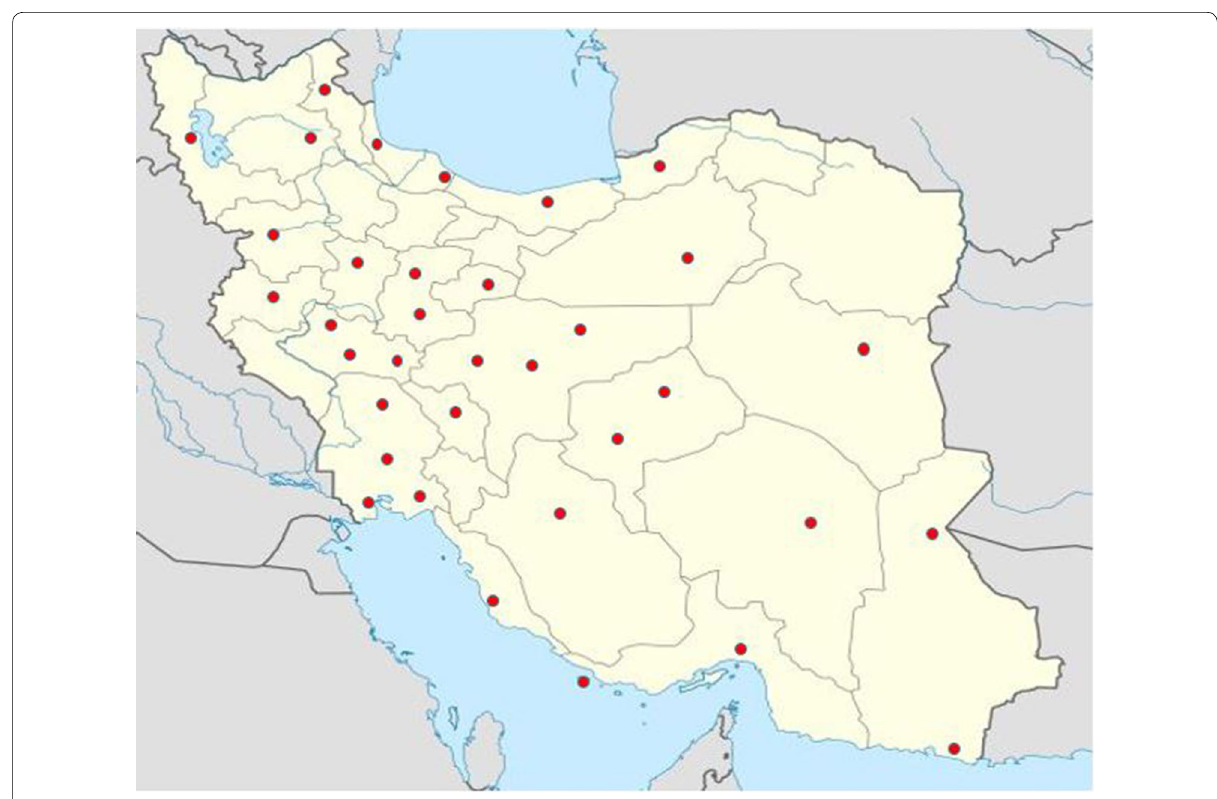
Fig. 1 Geographic distribution of sampling site from Iran’s